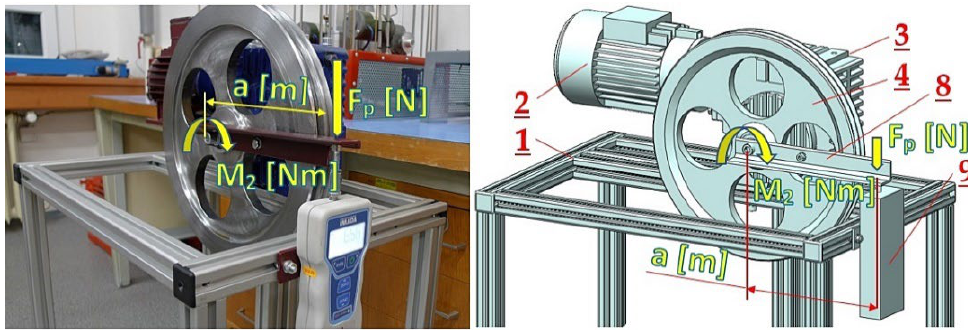
Figure 2. Detection of the friction moment in the driving unit ( 1 —machine frame, 2 —electric motor, 3 —worm gearbox, 4 —rope sheave, 8 —lever, 9 —force gauge). The end part of lever 8 was positioned by rotating the rotor of the electric motor manually 2 to be in contact with the tip of the force gauge 9 (type IMADA DST- 1000 [36]). To the terminals, connected to the star, of the electric motor 2 for the laboratory device drive, AC voltage 3 × 380 V was supplied, exciting the actual moment of engagement M 2(i) [N·m]. Moment M 2(i) [N·m] on the shaft of the sheave 4 generated, via lever 8 on the sensor tip of the force gauge 9 (type IMADA DST- 1000 [36]), pushing force F p(i) [N]. Actual torque